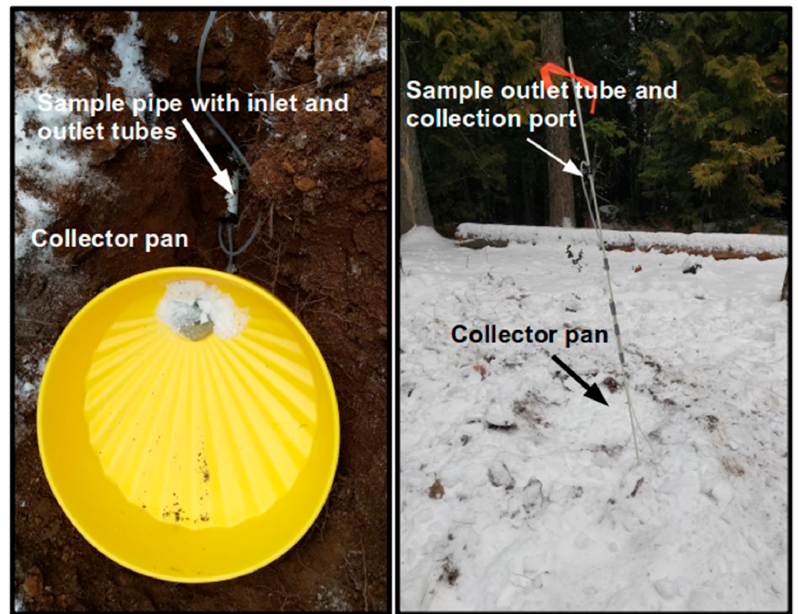
Figure 7. Snowmelt collection installation at Site #3.